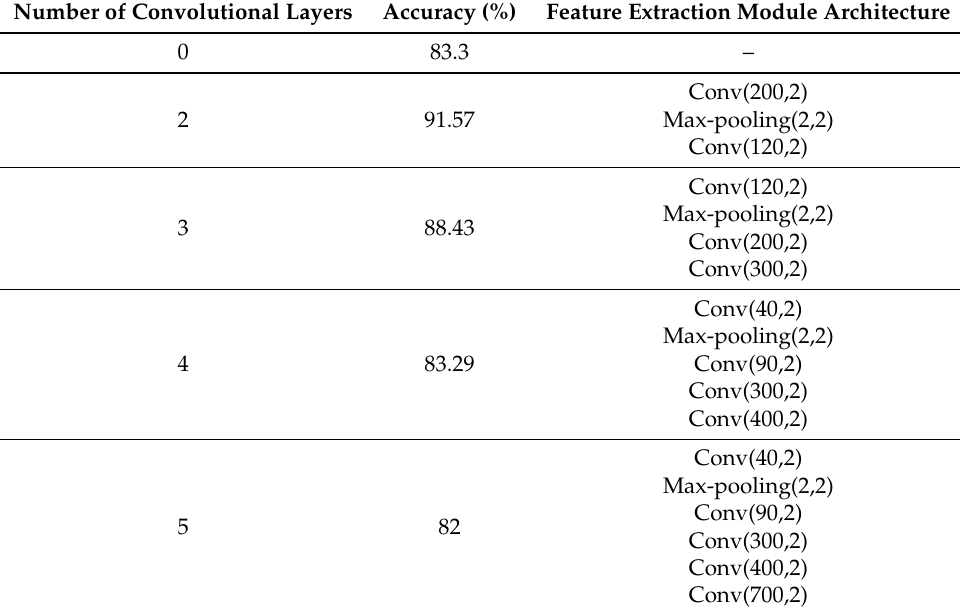
Table 8. Variation of the accuracy according to the number of layers using a grid of size 2 m × 2 m